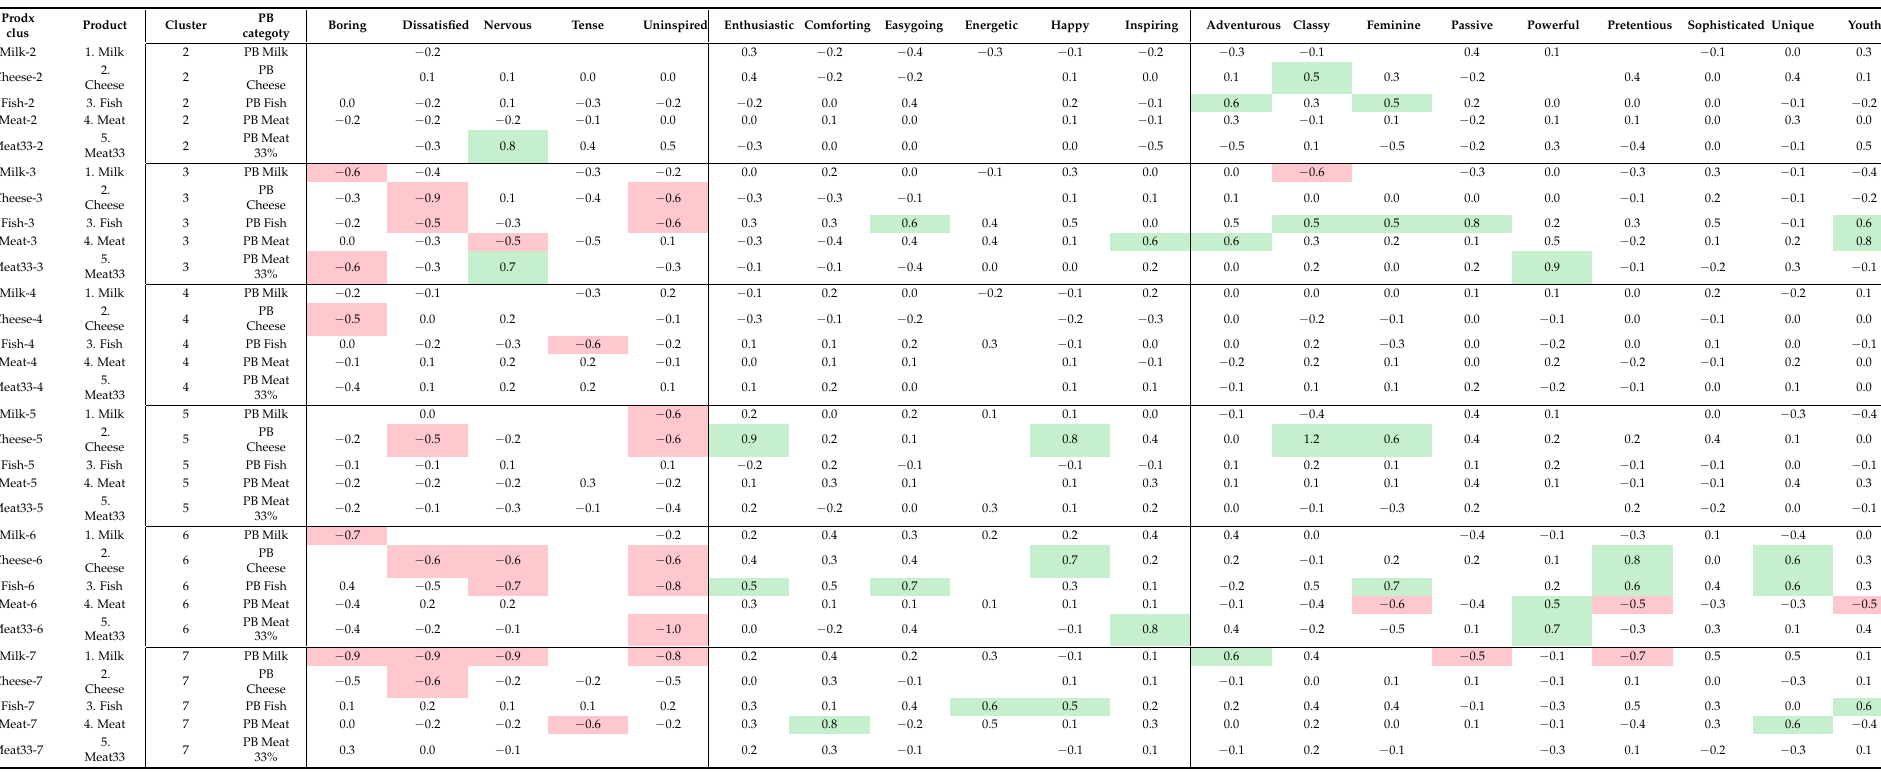
Table 3. Results following Penalty/Lift analysis for PB food categories in each of the six plant-based (PB) category discriminating clusters (Cluster 2 to Cluster 7), showing emotional and conceptual drivers of willingness to consume